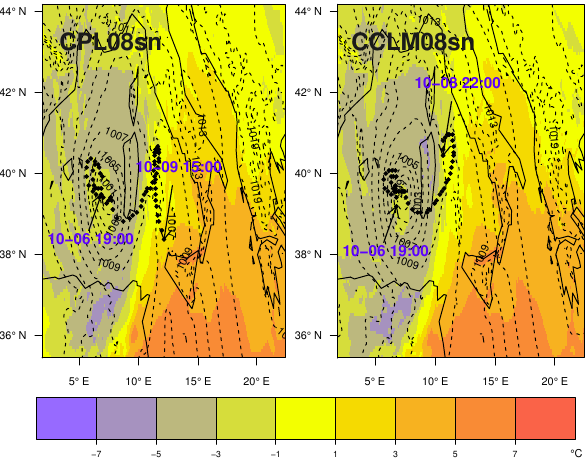
Figure 4. ME08; mean sea level pressure (hPa; dotted contours lines at 2hPa intervals) and temperature ( ◦ C: colored contours at 2 ◦ C in- tervals) at 700hPa in the coupled and atmosphere-only (0 . 08 ◦ ) with spectral nudging simulations, on 7 October 1996 at 18:00UTC. Black dots represent track of the medicane.